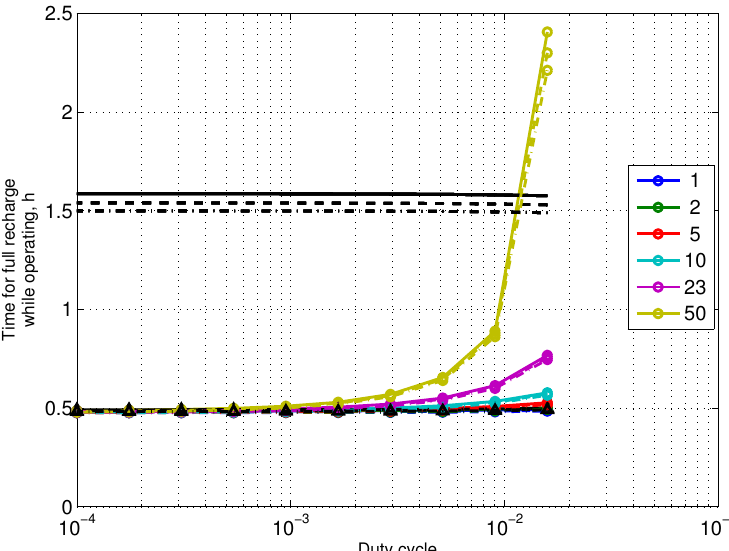
Figure 17. When M t = 1 and M r = 2, time for full recharge while operating with capacitor ( C s = 0.35 F). Non-WuR in black (without triangles), passive WuR in colors indicating number of nodes for different host duty cycles per node ( β (cid:48) w ). Semi-passive WuR in black with triangles. Line type indicates used